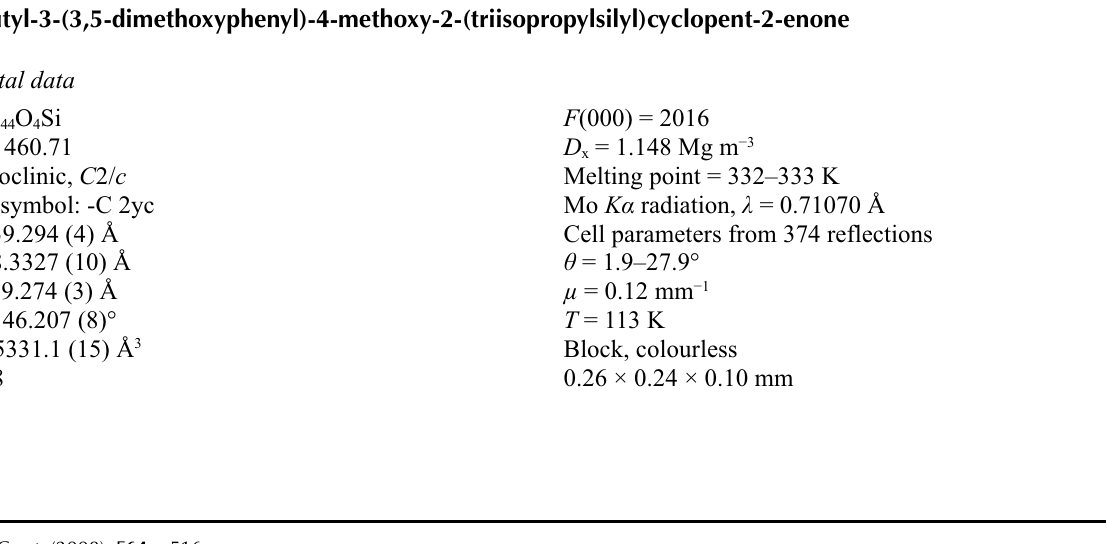
The molecule structure of title compound with atom numbering scheme. Displacement ellipsoids are drawn at the 50% probability level. H atoms are presented as a small spheres with the arbitrary